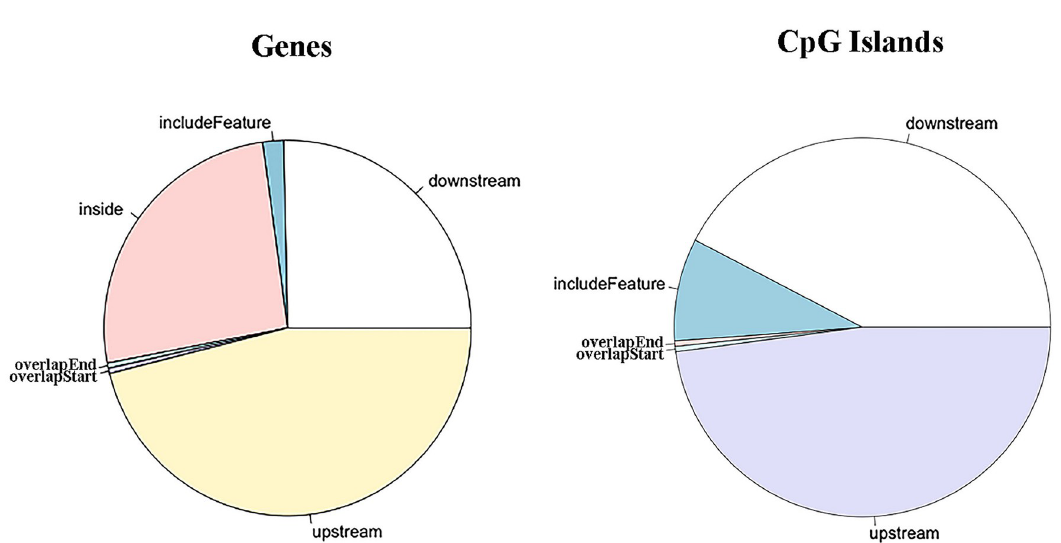
Fig 8. DMRs location distribution regarding genes and CpG islands. The labels in both pies represent: inside, DMR contained within the feature; include feature, the genomic feature is entirely included in the DMR; overlap start, the DMR extend over the start site of the feature; overlap end, the ending site of the feature overlaps with the DMR; downstream, DMR locates downstream the feature; upstream, the DMR aligns upstream the genomic feature.